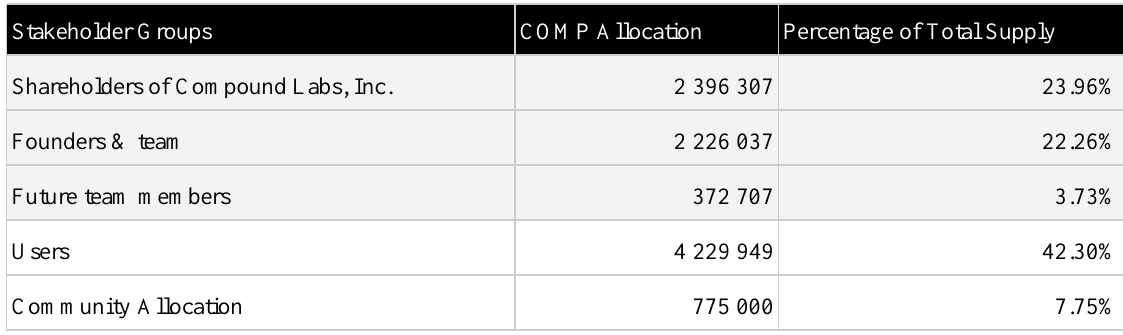
Table 4. COMP allocation to stakeholder groups